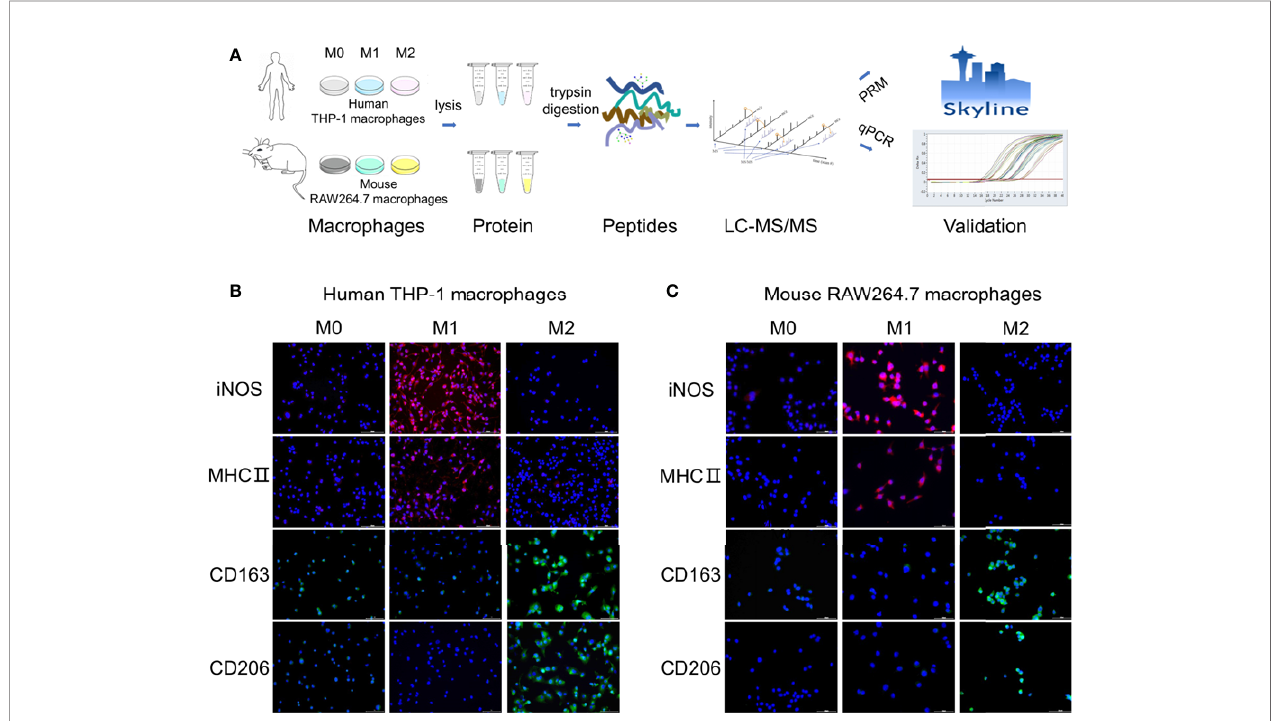
FIGURE 1 | Work fl ow of the study and validation of polarization models. (A) Work fl ow of this study about quantitative proteome analysis of three types of polarized macrophages from human THP-1 and mouse RAW264.7 cells. (B, C) Measurement of known markers for M1/M2 phenotypes in polarized human THP-1 macrophages (B) and mouse RAW264.7 macrophages (C) using the immuno fl uorescence staining method. Red: M1 macrophage markers iNOS and MHC II; Green: M2 macrophage markers CD163 and CD206; Blue: DAPI (nucleated cells) in untreated or differently treated cells. Scale bar = 10 m